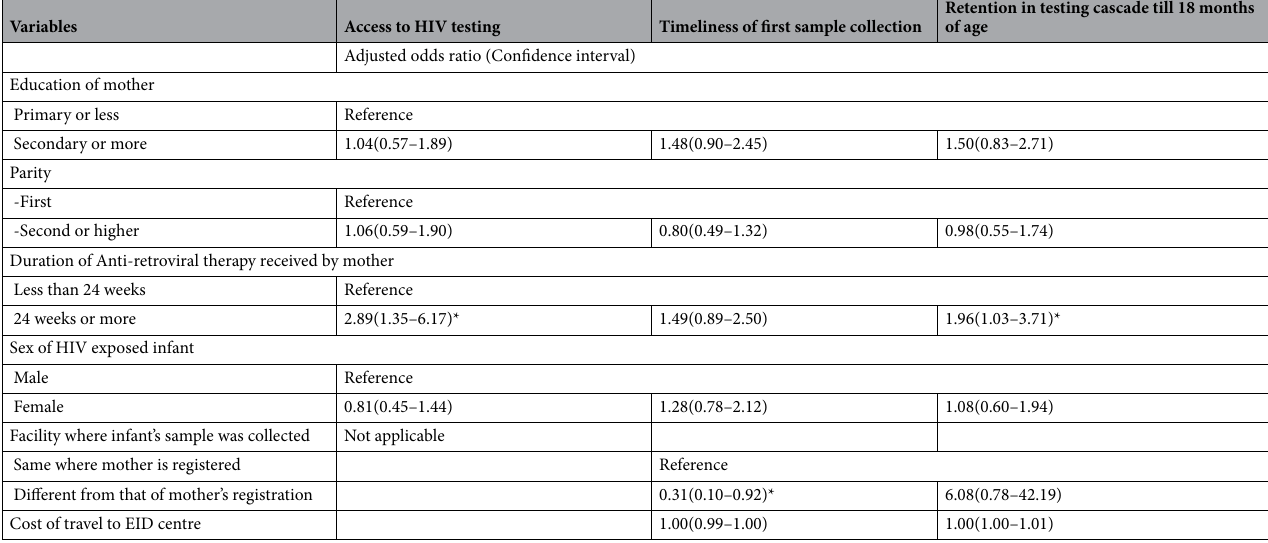
Table 2. Determinants of retention in early infant diagnosis (EID) testing cascade among HIV exposed infants. * p <